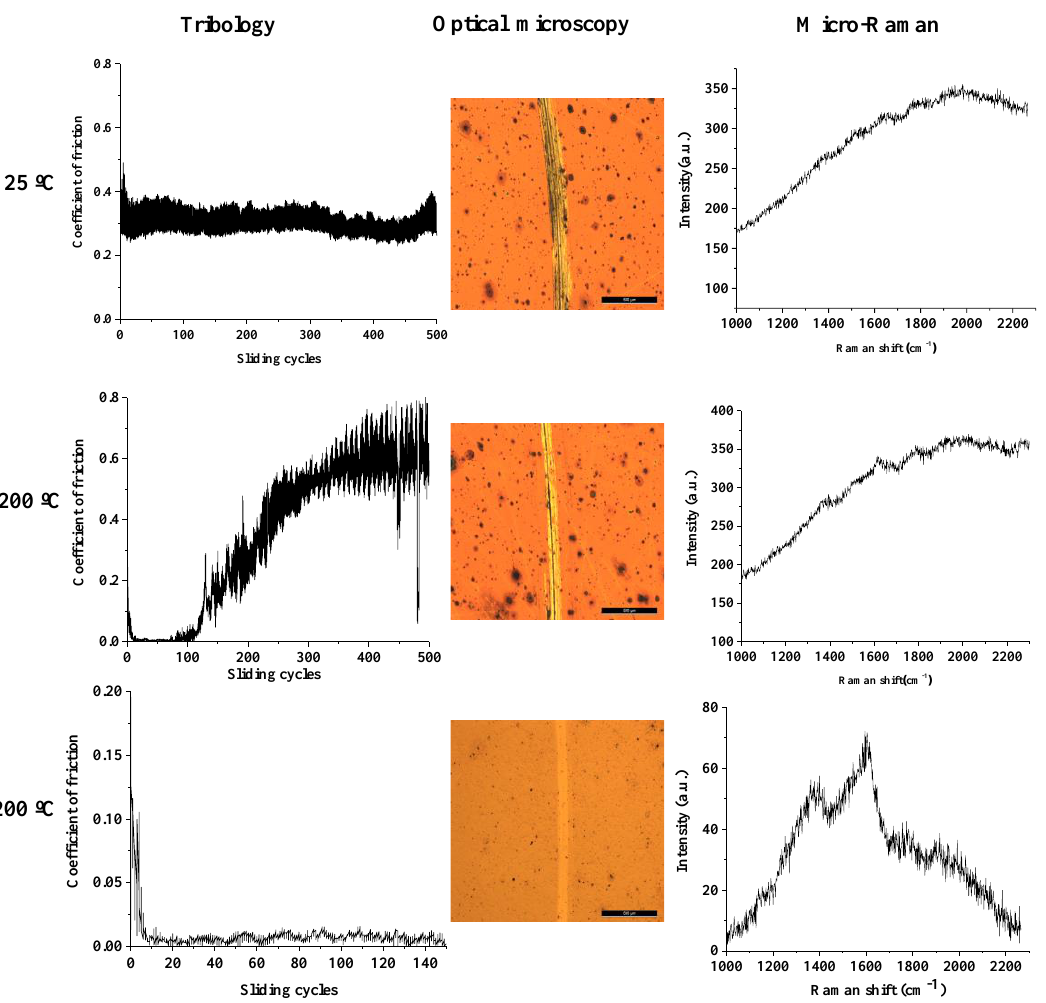
Figure 7. Coefficient of friction, optical macrographs, and micro-Raman characterization of the wear tracks of Cu-C15 after tribology tests, with 2 N load at different temperatures (bar = 500 μm).